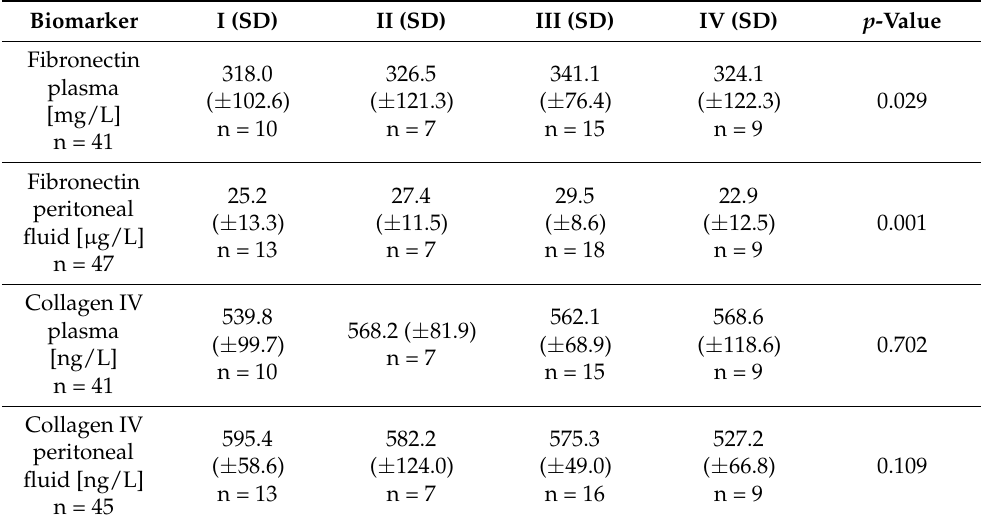
Table 3. Fibronectin and collagen IV concentrations depending on the stage of endometriosis. SD– standard deviation, one-way ANOVA (Kruskal–Wallis or Welch’s test).